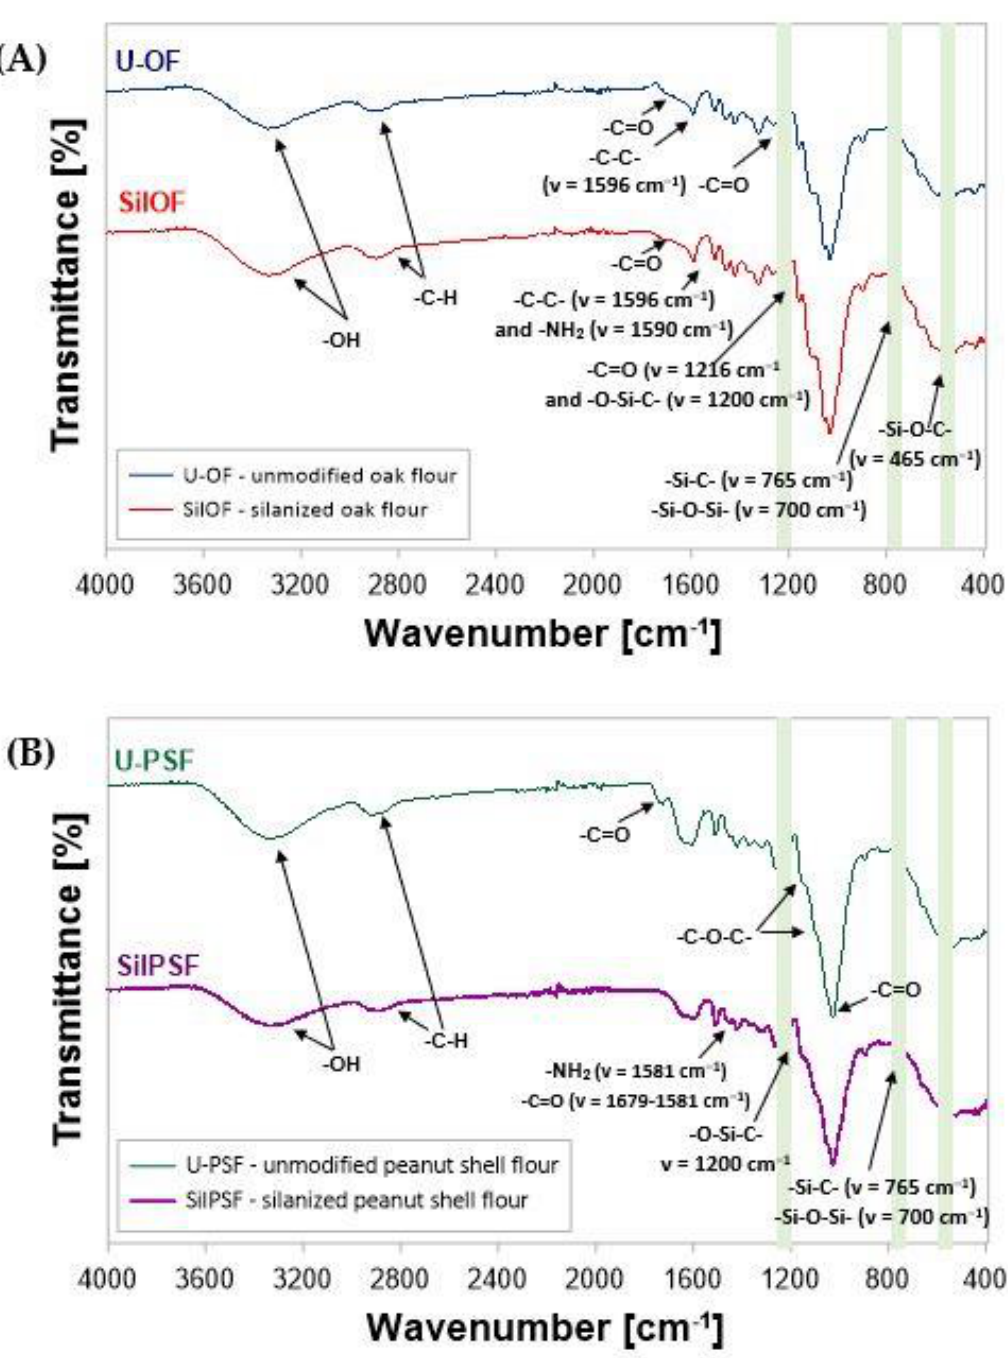
Figure 4. FT–IR spectrum of unmodified and chemically modified fillers in a form of ( A ) waste oak flour (U-OF—unmodified oak flour; SilOF—silanized oak flour) and ( B ) peanut shell flour (U-PSF—unmodified peanut shell flour; SilPSF—silanized peanut shell flour). Table 1. FT–IR analysis of waste bio-fillers.